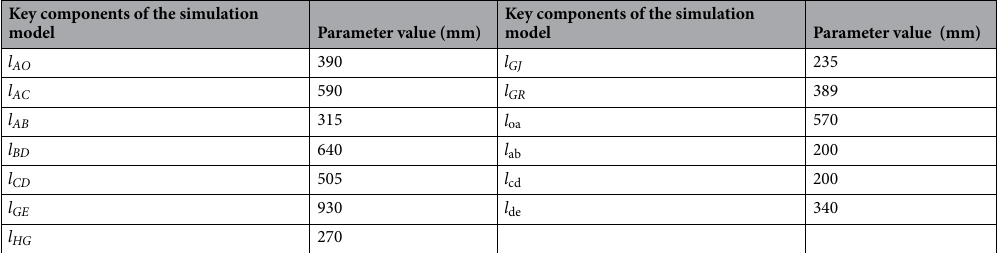
Table 15. Structural parameters of the key components of the simulation model.